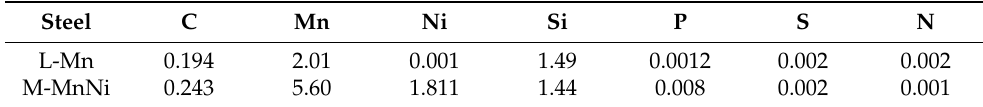
Table 1. Chemical composition of the steels